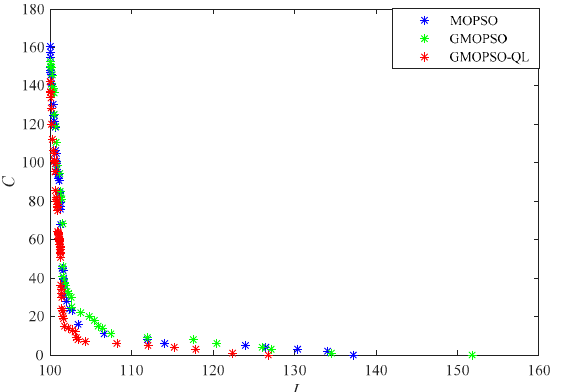
Figure 6. Pareto frontiers of MOPSO, GMOPSO, and GMOPSO-QL for UAV path planning in Case 1.